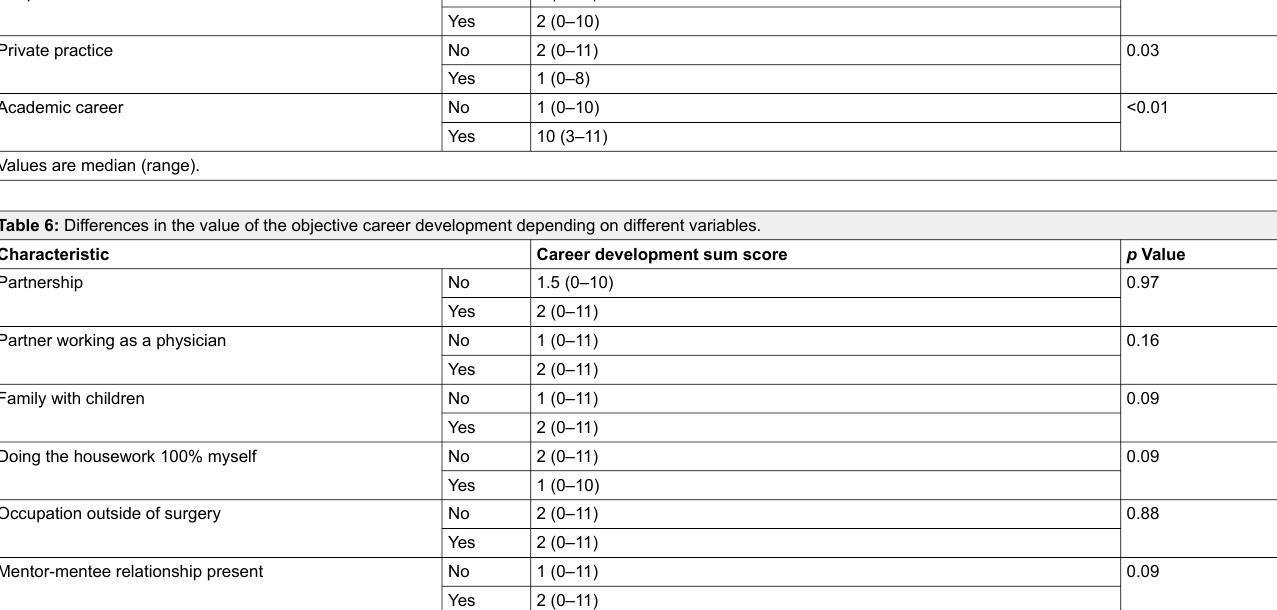
Table 5: Career development sum scores of different career aspirations. Career aspiration